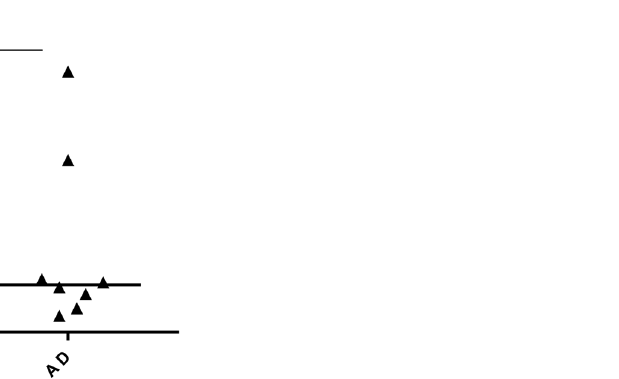
Figure 2. The analysis of FoxQ1 protein expression in primary human macrophages. Monocytes were isolated from blood of healthy donors (n = 3) and cultured for 6 days without stimulation (ns) or in the presence of IL-4. FoxQ1 expression (red) was assessed by immunofluorescent staining/confocal microscopy using goat anti- human FoxQ1 abs. Nuclei were visualized using DRAQ5 (blue). White arrows indicate cytoplasmic presence of FoxQ1 in macrophages. Representative images are shown. Scale bars: 10 µ m.